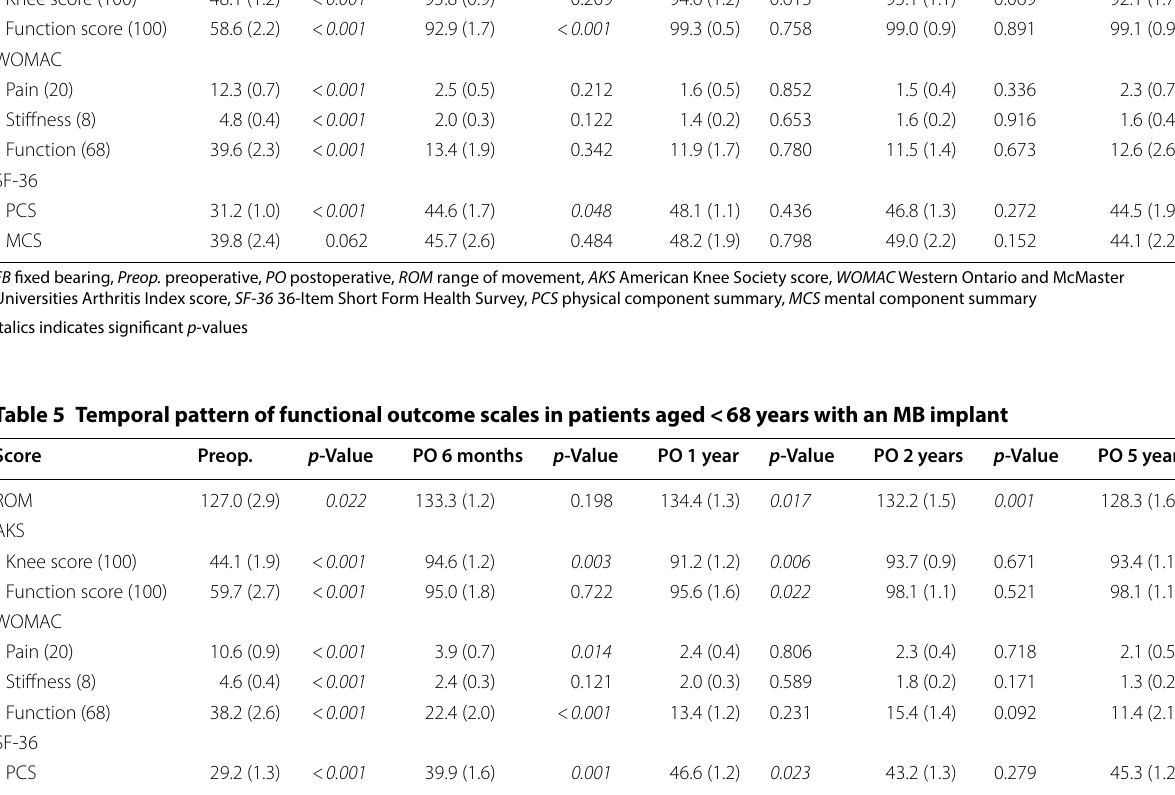
MB mobile bearing, Preop. preoperative, PO postoperative, ROM range of movement, AKS American Knee Society score, WOMAC Western Ontario and McMaster Universities Arthritis Index score, SF-36 36-Item Short Form Health Survey, PCS physical component summary, MCS mental component summary Italics indicates significant p